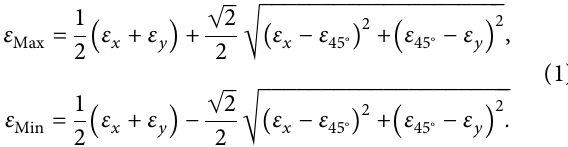
0.51.01.52.02.53.0 Figure 17: Variation trends of AAF of WC-Z in the Z -direction at different intensities: (a) left hole and (b) right hole. Figure 18: Variation trends of AAF of WC-XZ in the Z -direction at different intensities: (a) left hole and (b) right hole. Figure 19: Strain